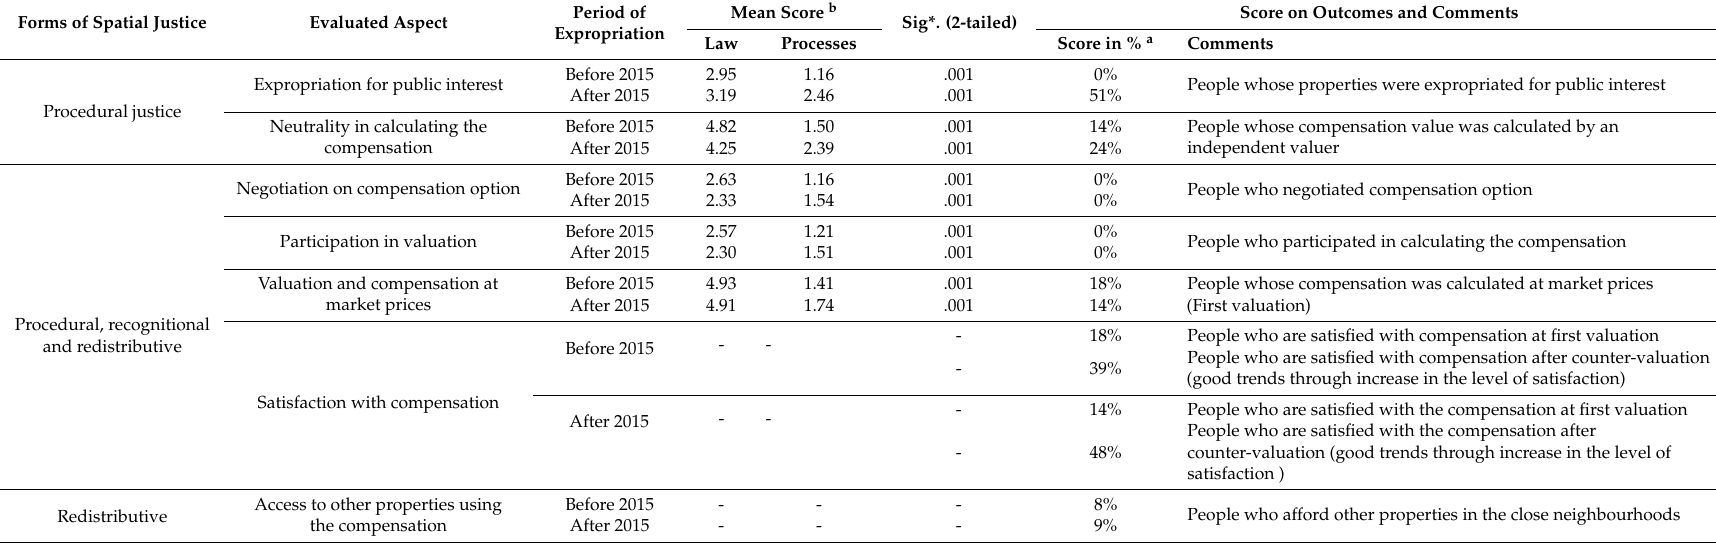
Table 2. Trends of spatial justice within the expropriation law, its implementation practices and